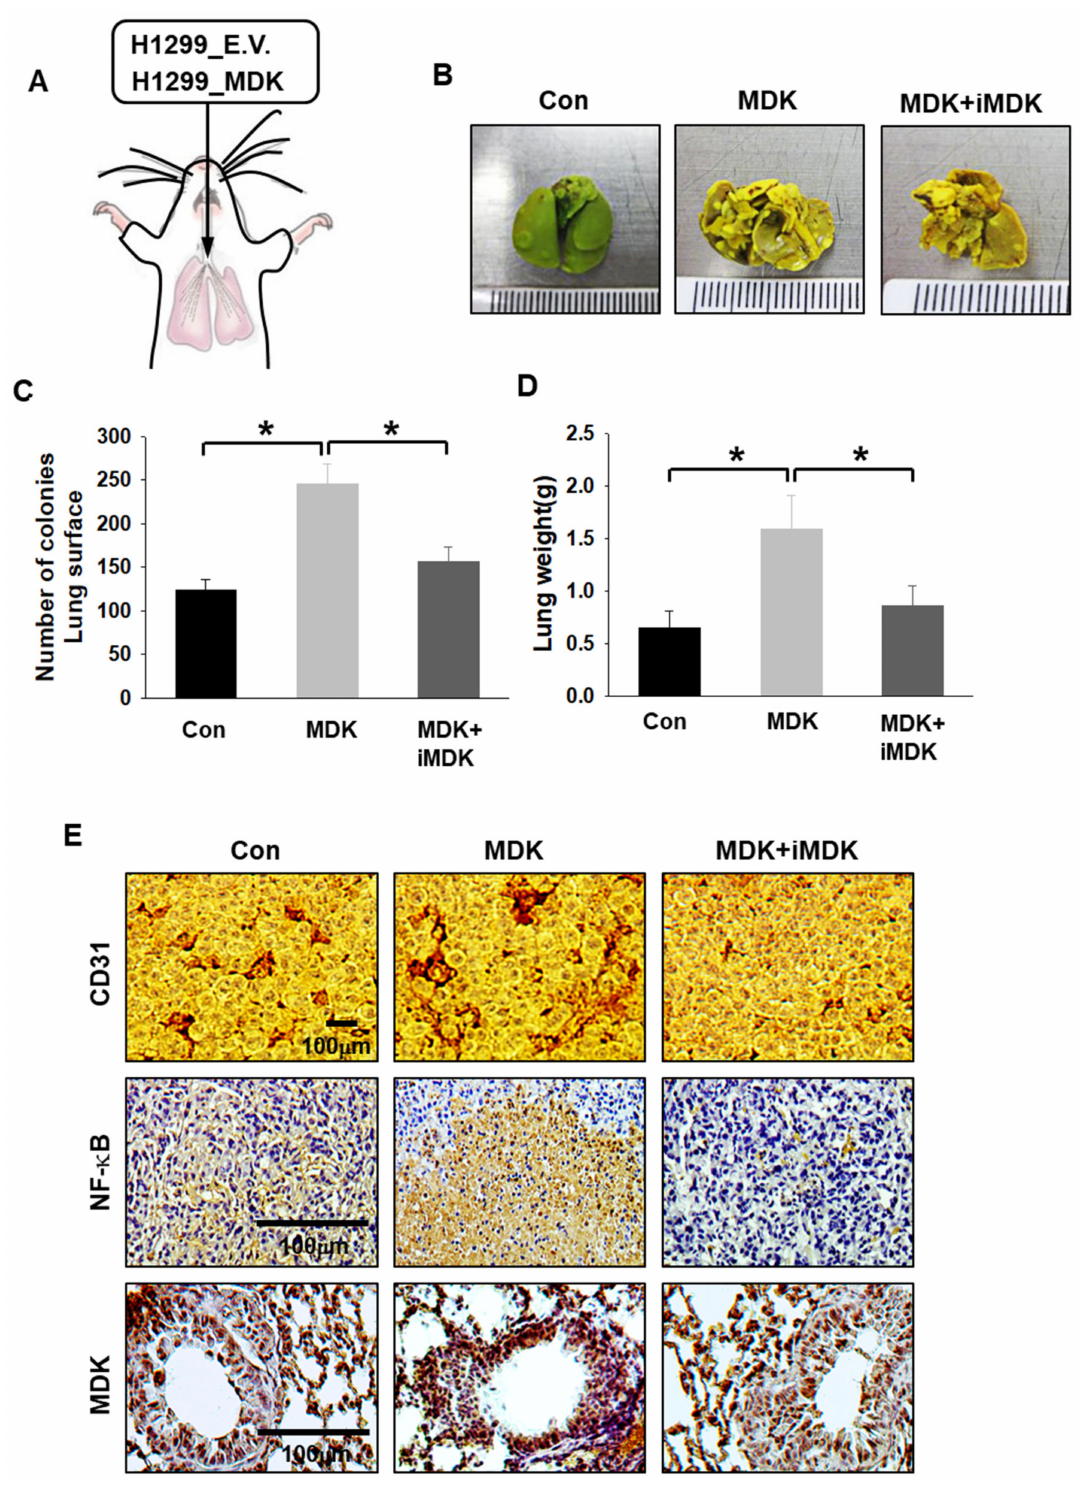
Figure 6. iMDK decreases MDK-induced lung tumorigenesis. ( A ) Schematic diagram of the experimental system to induce the lung orthotopic model in mice by intratracheal injection with the H1299 stable cell line. ( B ) Transfected cells were intratracheally injected into nude mice (1 × 10 6 cells / mouse), and lung tumor images were measured two months after injection. The control and MDK expression groups were intraperitoneally treated with DMSO (100 µ L / 1 time / 2 days) and iMDK (9 mg / kg / 1 time / 2 days). At the first sign of morbidity, mice were euthanized and mice lungs were isolated and stained with Bouin’s